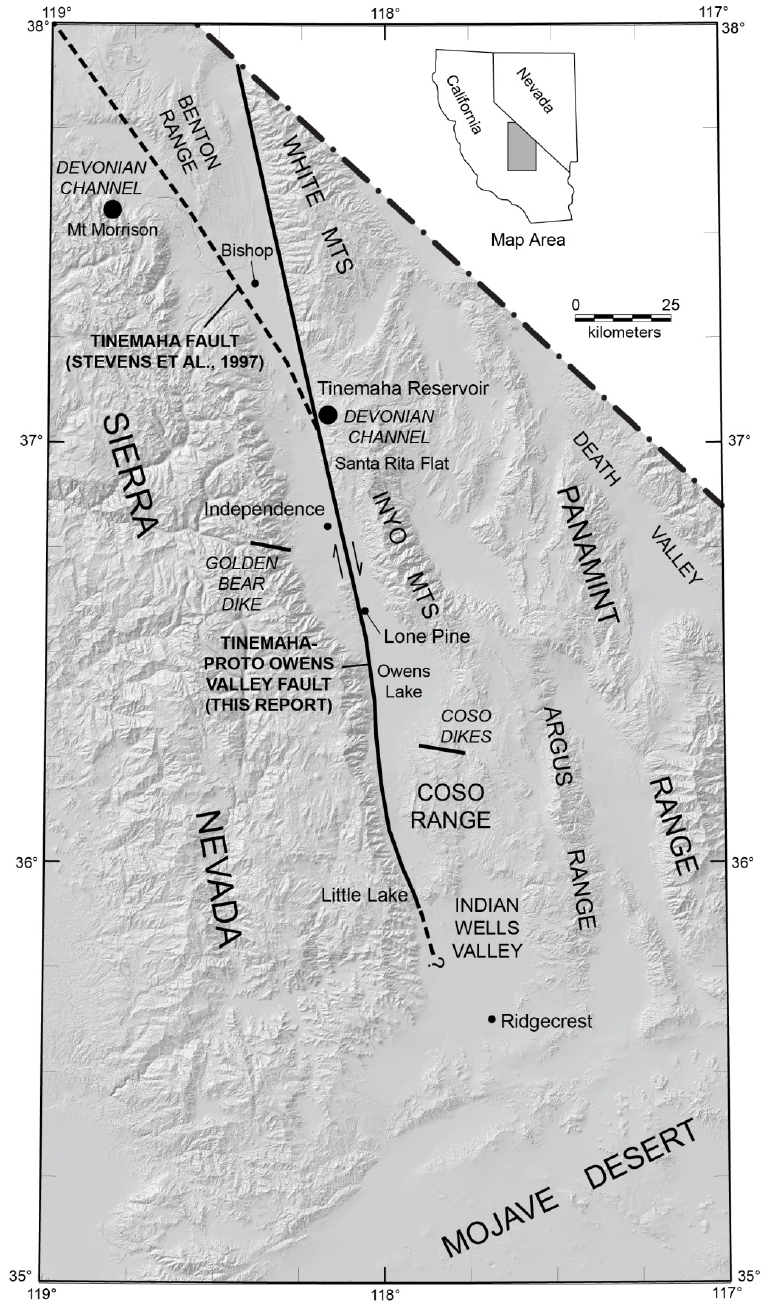
Figure 11. Map showing interpreted location of the Tinemaha-proto Owens Valley Fault (T-pOVF, solid line), which was later reactivated by the modern White Mountains, Owens Valley, and Little Lake fault zones. Dashed line = Tinemaha Fault of Stevens et al. [34] which is herein abandoned. Offsets of a Devonian channel [34] and the Coso-Golden Bear dikes [15] indicate a total of ca. 65 km of right-lateral displacement since late Cretaceous time. See text for further